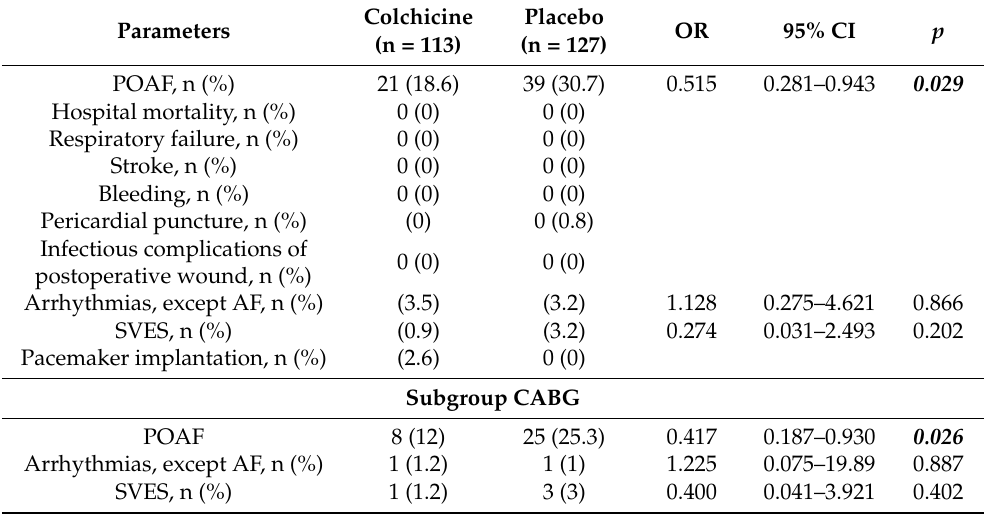
Table 3. Clinical outcomes and